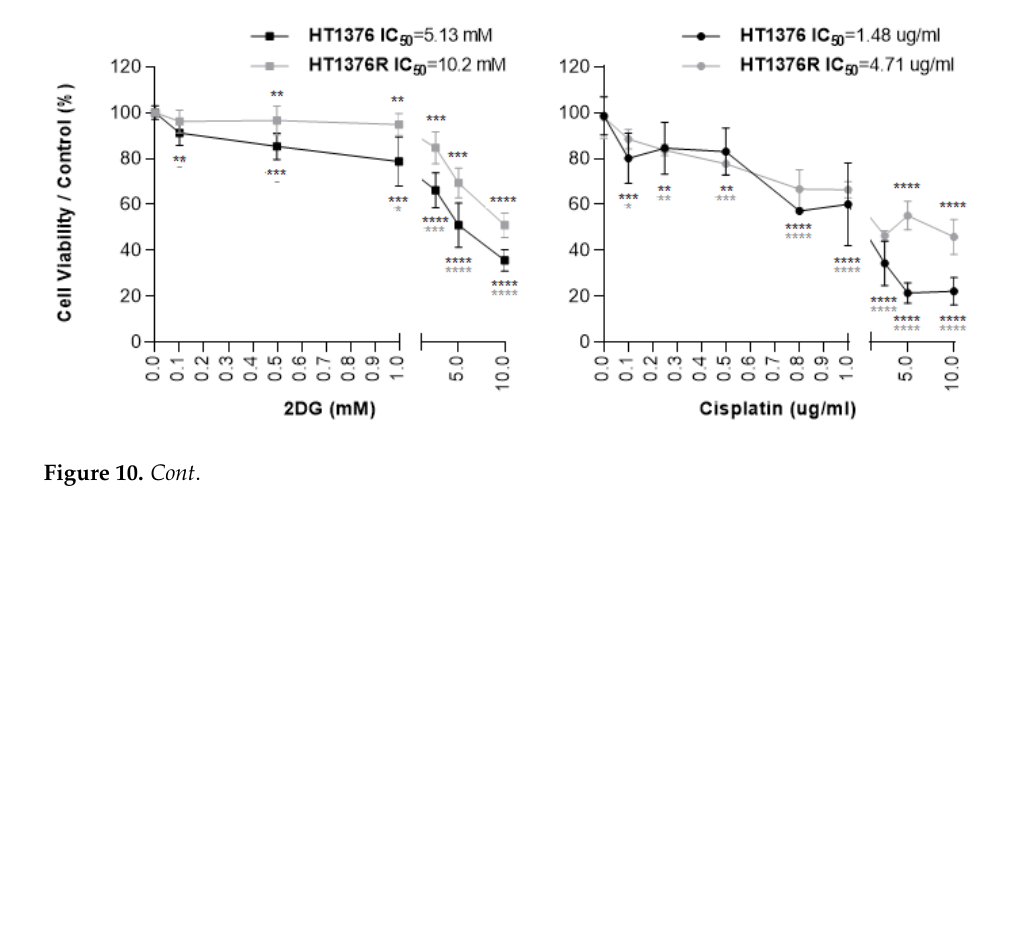
Figure 10. Effect of 2DG and cisplatin on the viability of HT1376 and HT1376R urothelial bladder carcinoma cell lines, detected by the sulforhodamine B assay at 72 h post-treatment. In ( A ), dose response curves and IC 50 values are shown. Results are expressed as normalized means ± SD of at least 3 independent experiments, each one in triplicate. The equation for IC 50 determination is Y = Bottom + (Top − Bottom)/(1 + 10 ((LogIC50 − X)*HillSlope)) . * above the graph lines: ** p < 0.01, *** p < 0.001 and **** p < 0.0001 for treatment (2DG or cisplatin) of HT1376R versus HT1376 cells; * below the graph lines: * p < 0.05, ** p < 0.01, *** p < 0.001 and **** p < 0.0001 for treatment (2DG or cisplatin) of HT1376 (black *) or HT1376R (grey *) cells versus control condition (PBS 1×). In ( B ), the effect of 2DG and cisplatin IC 50 s in HT1376 and HT1376R, administered alone and in combination (at indicated dos- ages) is shown. Results are expressed as normalized means ± SEM of at least 3 independent experi- ments, each one in triplicate. * p < 0.05, ** p < 0.01, *** p < 0.001 and **** p < 0.0001 for treatment (2DG and cisplatin, alone or combined) versus control condition (PBS 1×). #### p < 0.001 for combined treat- ment (at indicated dosages) versus cisplatin IC 50 treatment.